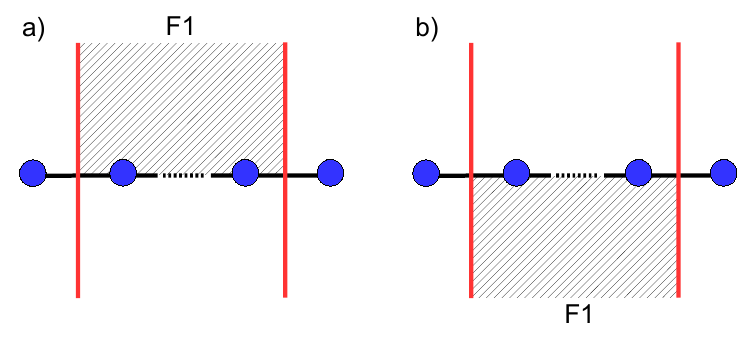
Figure 21 . Brane setups of the long mesons (a) B and (b) (cid:0) e B .